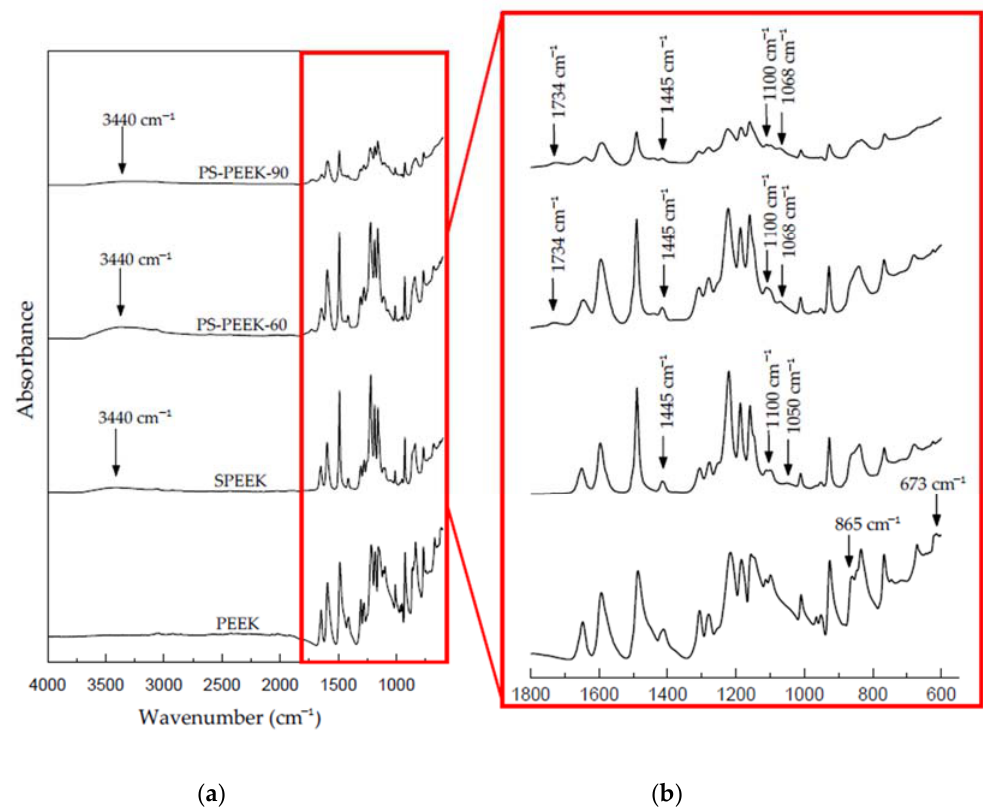
Figure 1. Comparative FTIR spectra of PEEK, SPEEK, PS-PEEK-60 and PS-PEEK-90 samples samples ( a ) and enlargement of the graph in the region from 1800 to 550 cm − 1 to highlight the differences between PEEK and the respective treatments ( b